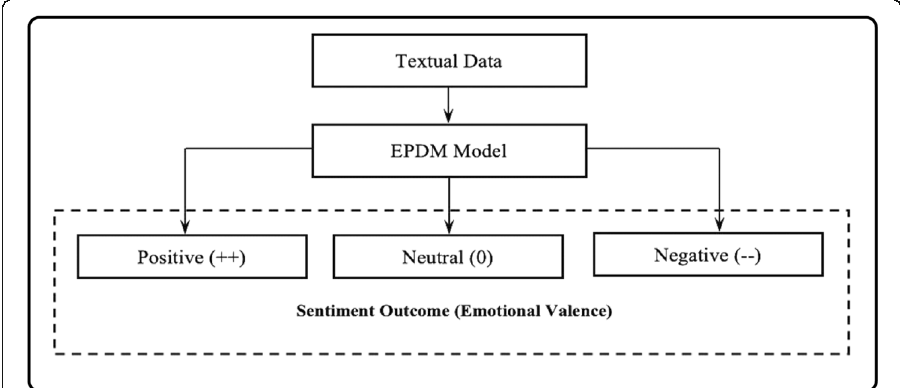
Fig. 6 Sentiment analysis and implementation outcomes of the EPDM